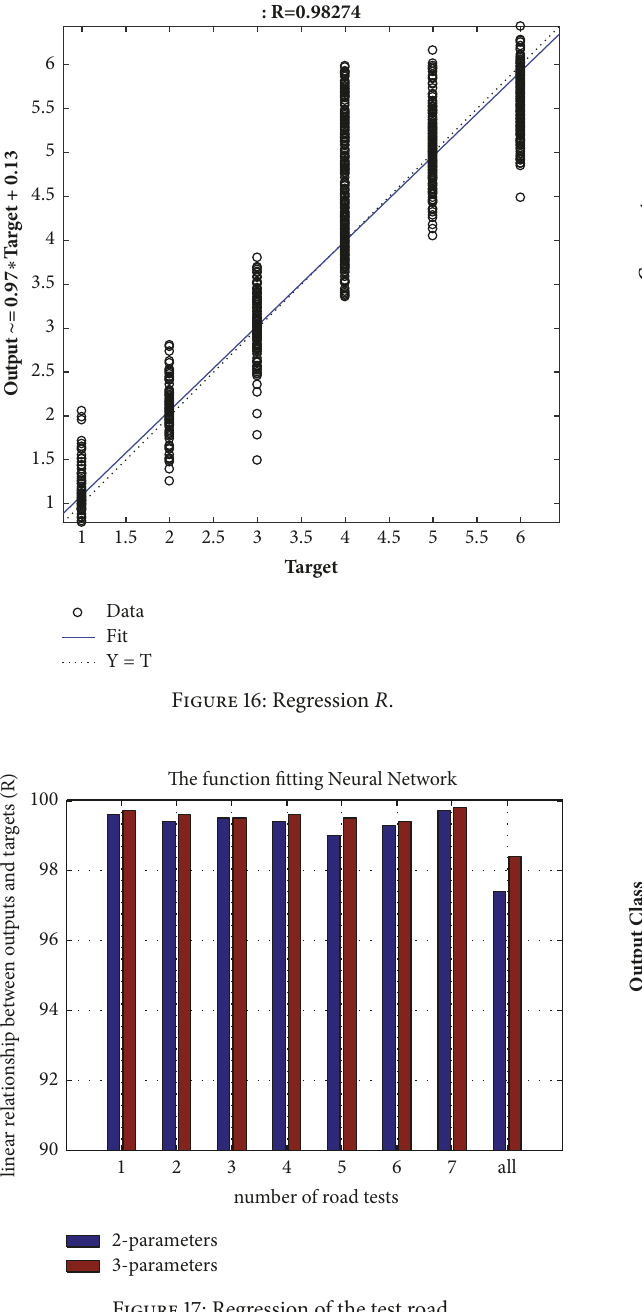
Figure 17: Regression of the test road.